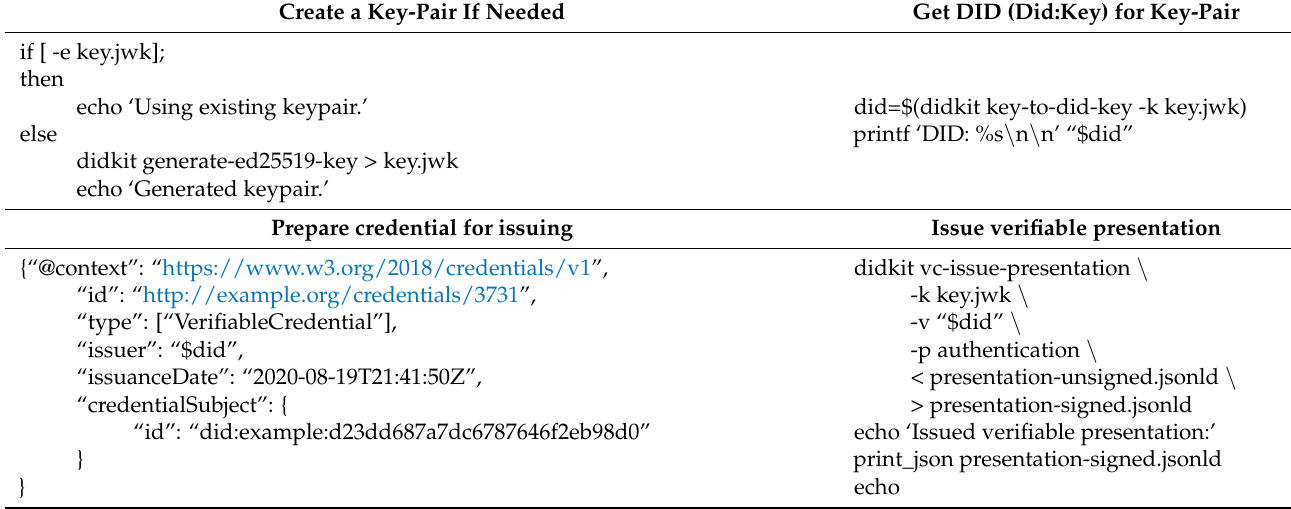
Table 3. Certification of vehicle accident data.